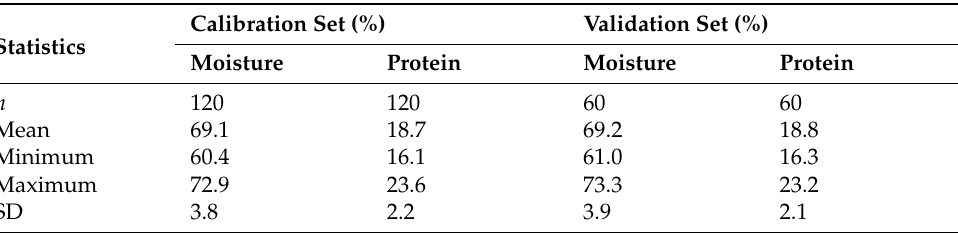
Table 4. Moisture and protein content in living mealworm larvae (values given in % of wet weight) for calibration and validation sets.